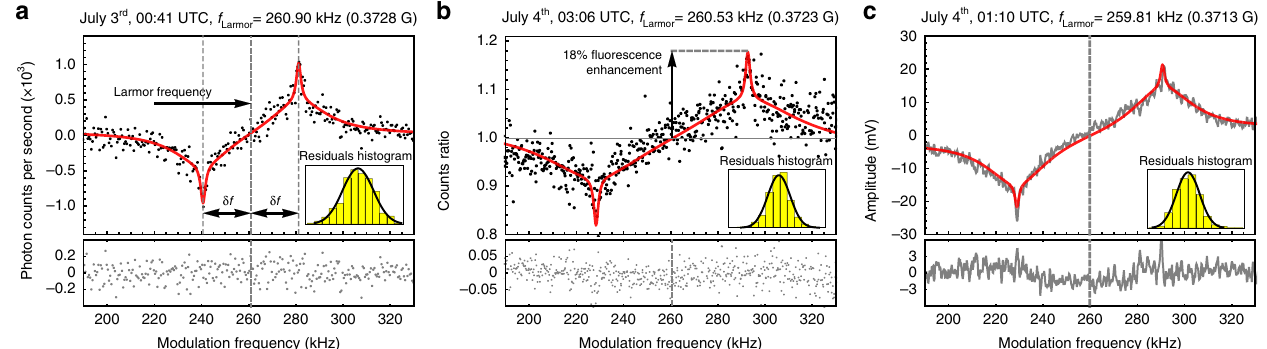
Fig. 3 Magneto-optical resonances. The resonances were obtained by sweeping the frequency of the intensity-modulated laser beam with three concurrent data acquisition methods. a Online differential counter for a modulation duty cycle of 20% and I meso between the peaks, which are separated by twice the dither excursion δ f = 20.2 kHz. b Ratio of the photon counts per dither period averaged over 2 s. The modulation duty cycle was 30%, excursion δ f = 30.8 kHz and calculated mesospheric irradiance I meso of 300 ms, modulation duty cycle 20%, excursion δ f = 30.8 kHz, and calculated mesospheric irradiance I meso Lorentzian fi t shows a broad and a narrow width of ~30 and 2 kHz, respectively, consistent with two relaxation mechanisms due to velocity-changing collisions (fast) and spin-exchange collisions (slow) of sodium with N 2 and O 2 molecules. The residuals of the fi ts are shown below each resonance and obey a normal distribution according to the Gaussian fi t of the residuals